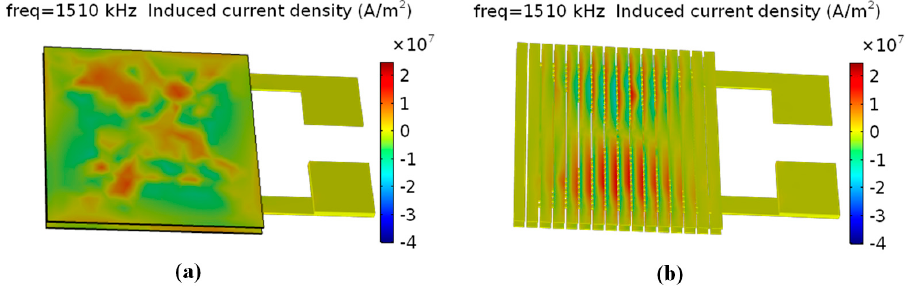
Figure 3. Distribution of surface inductive current density of micro-inductor. ( a ) Non-patterned magnetic film; ( b ) patterned magnetic film.